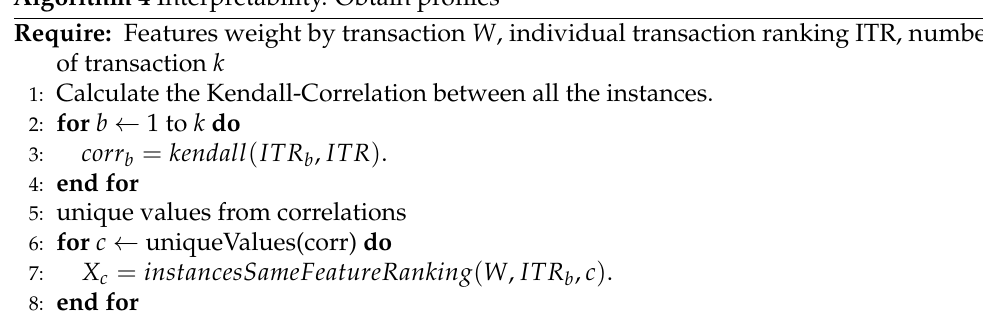
Algorithm 4 Interpretability. Obtain